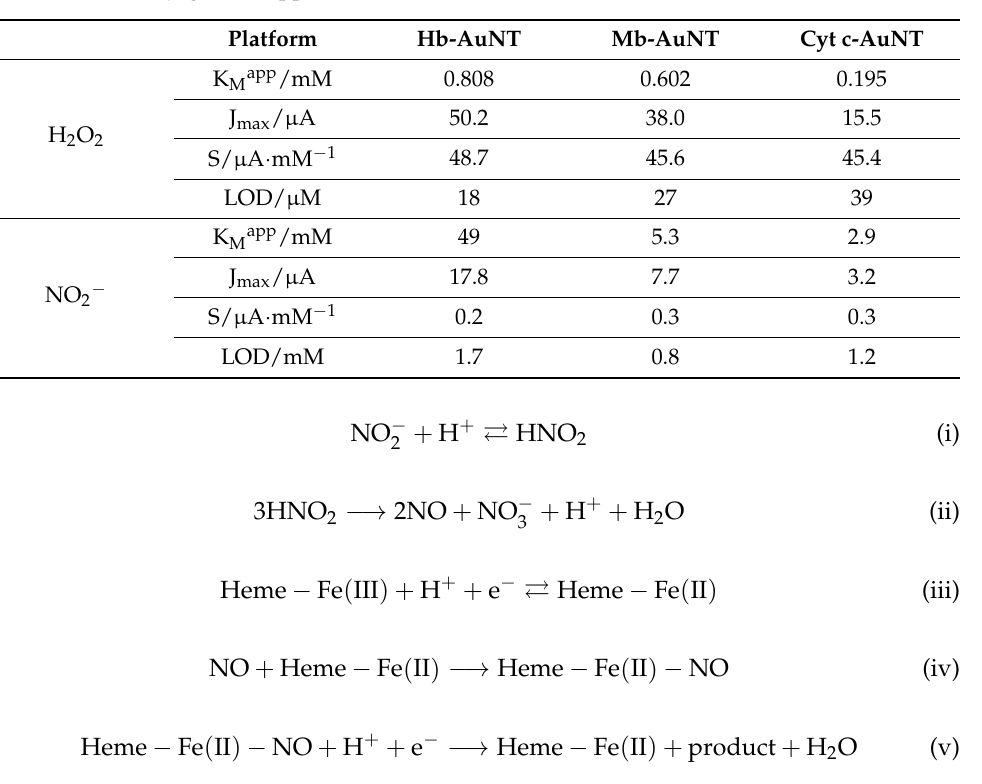
Figure 5. Electrocatalytic response of the Hb-AuNT-GC system for H 2 O 2 detection. ( a ) Cyclic voltammograms recorded after multiple additions of H 2 O 2 in a 10 mM phosphate buffer solution at pH 7.4, ( b ) plot of the current intensity measured at the potential maximum as a function of H 2 O 2 concentration, and ( c ) Lineweaver–Burk plot. Table 2. Electrocatalytic parameters determined for H 2 O 2 and NO 2 − analytes in the presence of heme-based bioconjugates dropped in a GC